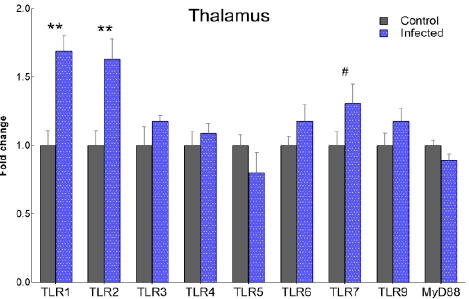
Figure 8. Gene expression of TLR1-7 , TLR9, and MyD88 in the thalamus of clinically affected tg338 mice intracerebrally inoculated with scrapie-positive inoculum versus controls (scrapie-negative inoculum). Results are expressed as the mean ± SEM fold change with respect to controls (expressed as a score of 1). Mean scores were compared using the Student’s t-test or Mann–Whitney U test for normally and non-normally distributed data, respectively. # p < 0.1, **p < 0.01.